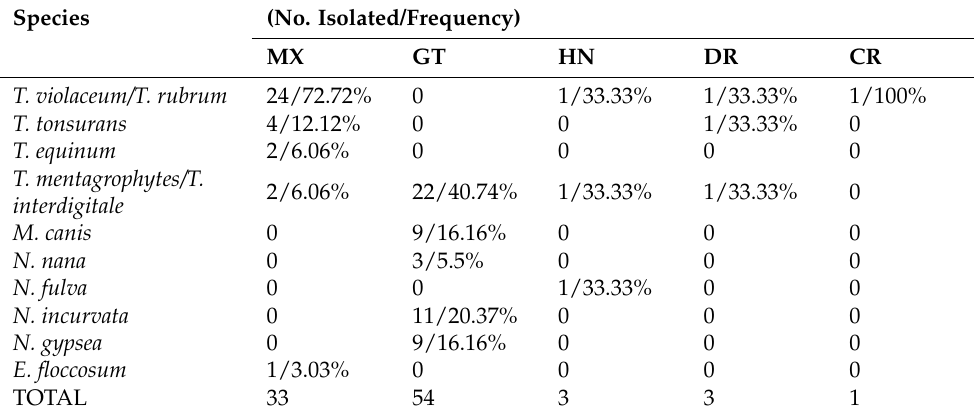
Table 6. Frequency of species genotypically identified using Bayesian inference according to their geographic